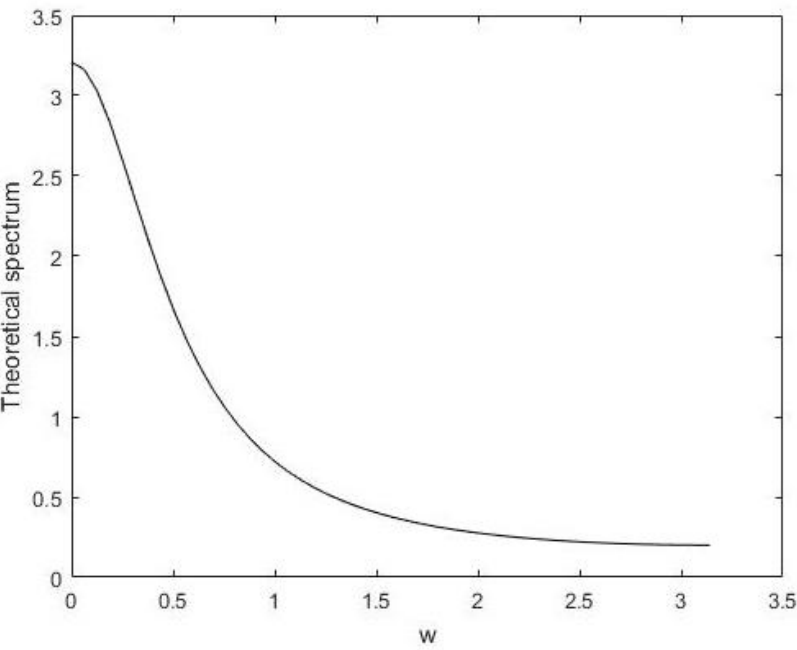
Figure 3. The theoretical spectrum of the DCGINAR(1) model at α = 0.6, θ = 0.7 and µ = 1.8.